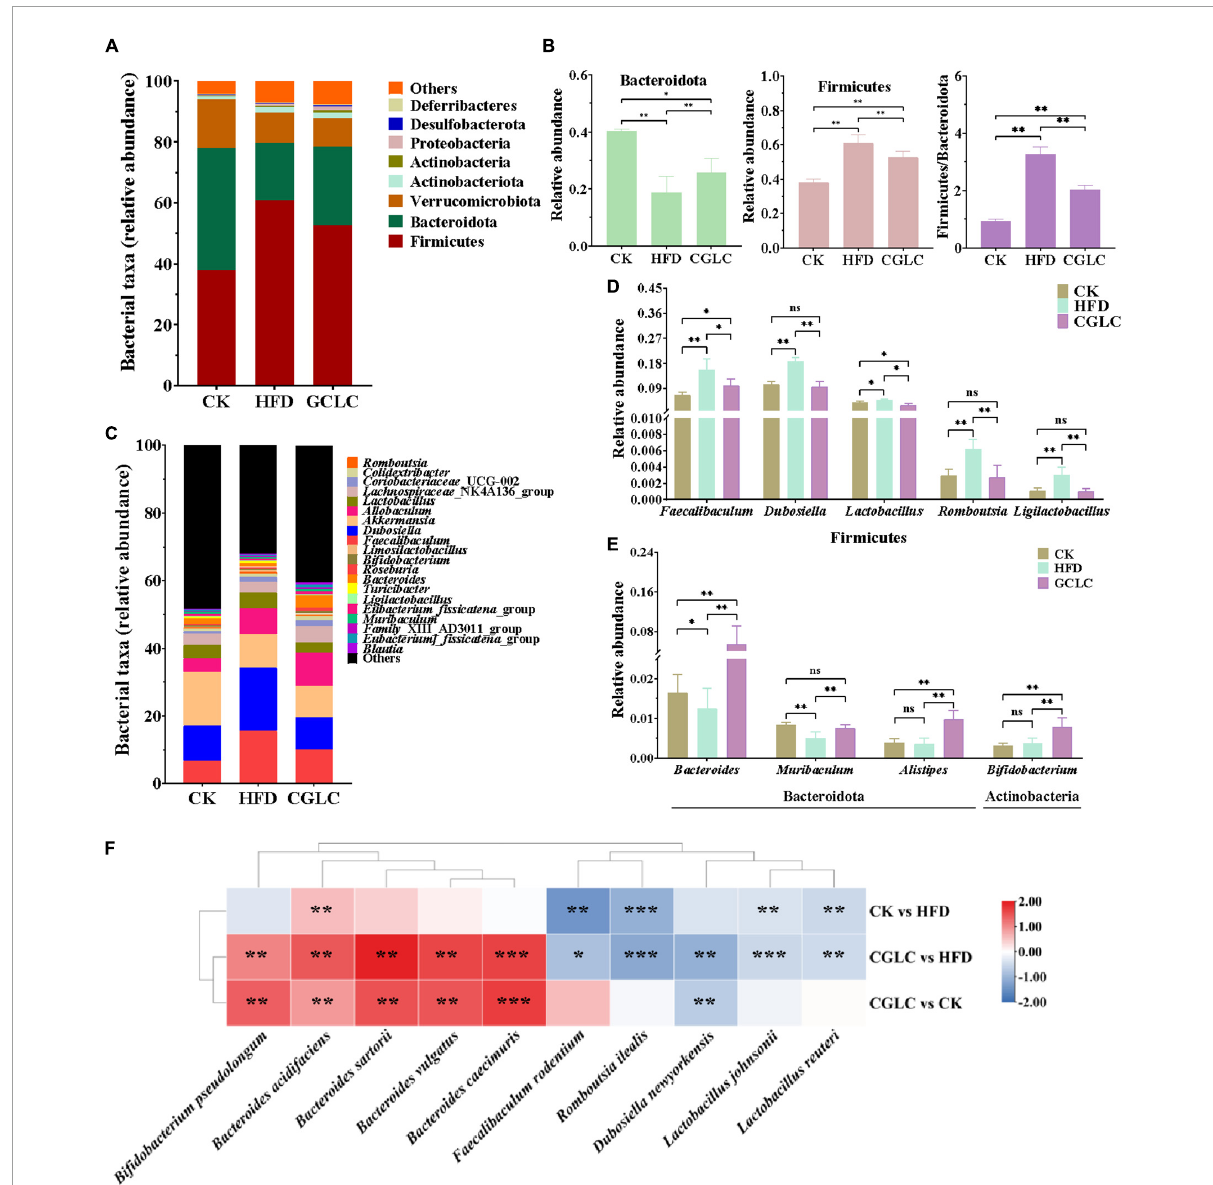
FIGURE4 Cordyceps guangdongensis lipid-lowering compound formula improved the composition of gut microbiota in HFD mice. Average percent of community abundance on phylum level in three groups (A) . Relative community abundance of Bacteroidota and Firmicutes and Firmicutes/Bacteroidetes community abundance ratio in fecal samples of three samples (B) . Average percent of community abundance at the genus level in three groups (C) . Relative community abundance of eight genera significantly downregulated (D) and upregulated (E) in the comparison of HFD and CGP groups. (F) Heat map showing the difference value both of two groups (log2 fold change). ns, no significant difference; ∗ , significant difference ( P < 0.05), ∗∗ and ∗∗∗ , highly significant difference ( P < 0.01 and P <